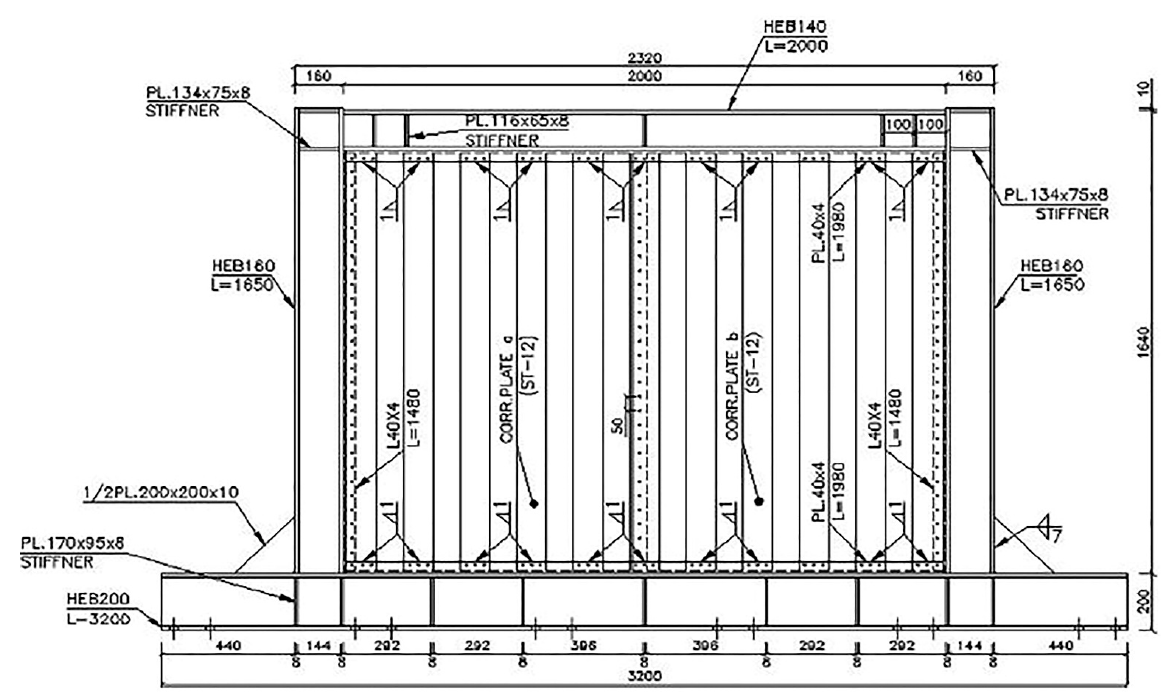
Figure 3. Details of the specimen tested by Emami et al. Adapted from ref. [9].